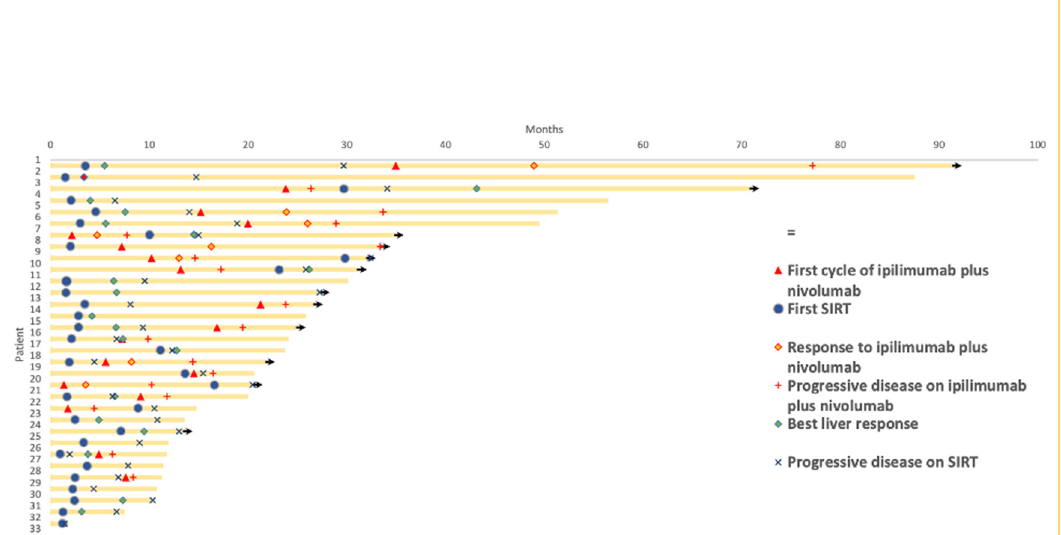
Figure 3. Swimmer plot. Follow up of each patient from the diagnosis of metastatic disease until death or end of study, time of start of ipilimumab plus nivolumab and first SIRT, best overall response to ipilimumab plus nivolumab and best liver response to SIRT and moment of progressive disease on ipilimumab plus nivolumab and on SIRT.